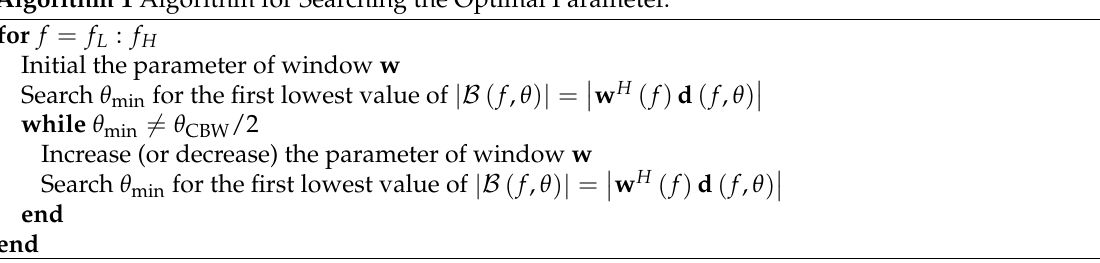
Algorithm 1 Algorithm for Searching the Optimal